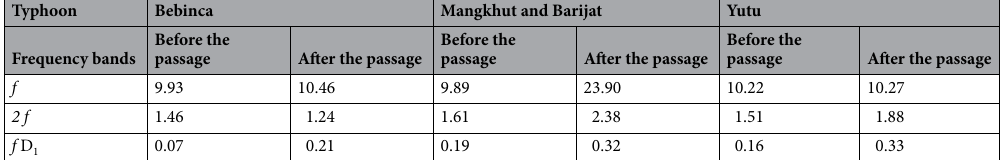
Before the passage After the passage